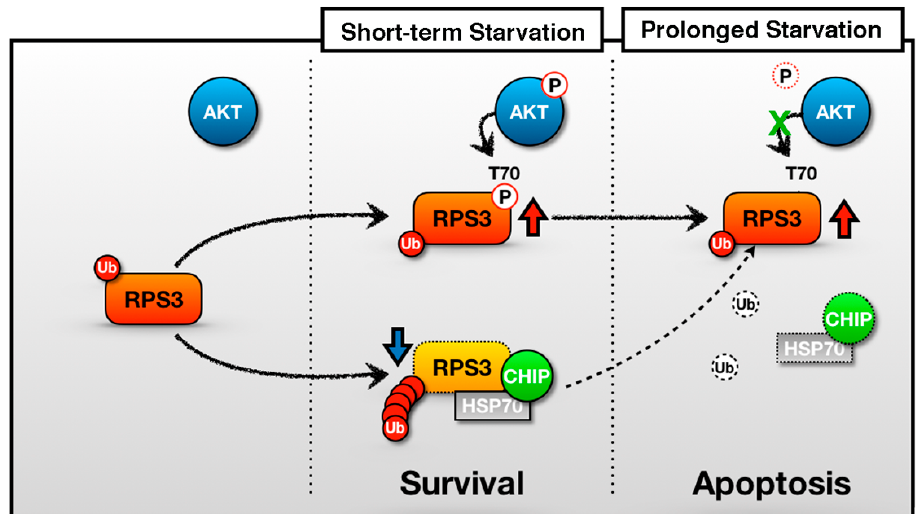
Figure 6. A schematic of the representative role of RPS3 in STS and PS. In the short-term starvation condition, RPS3 T70 is phosphorylated by p-Akt and its phosphorylated form induces protein stability. Moreover, RPS3 (the nonphosphorylated form) is regulated by UPS-dependent degradation with a chaperone-E3 ligase complex, HSP70–CHIP, leading to neuronal cell survival. Otherwise, after prolonged starvation, the interaction of the RPS3 and HSP/CHIP complex is significantly reduced, and its ubiquitination is decreased. RPS3 is highly expressed and induces neuronal apoptosis. Red arrow = protein stability is increased; blue arrow and dotted line = protein stability is decreased.